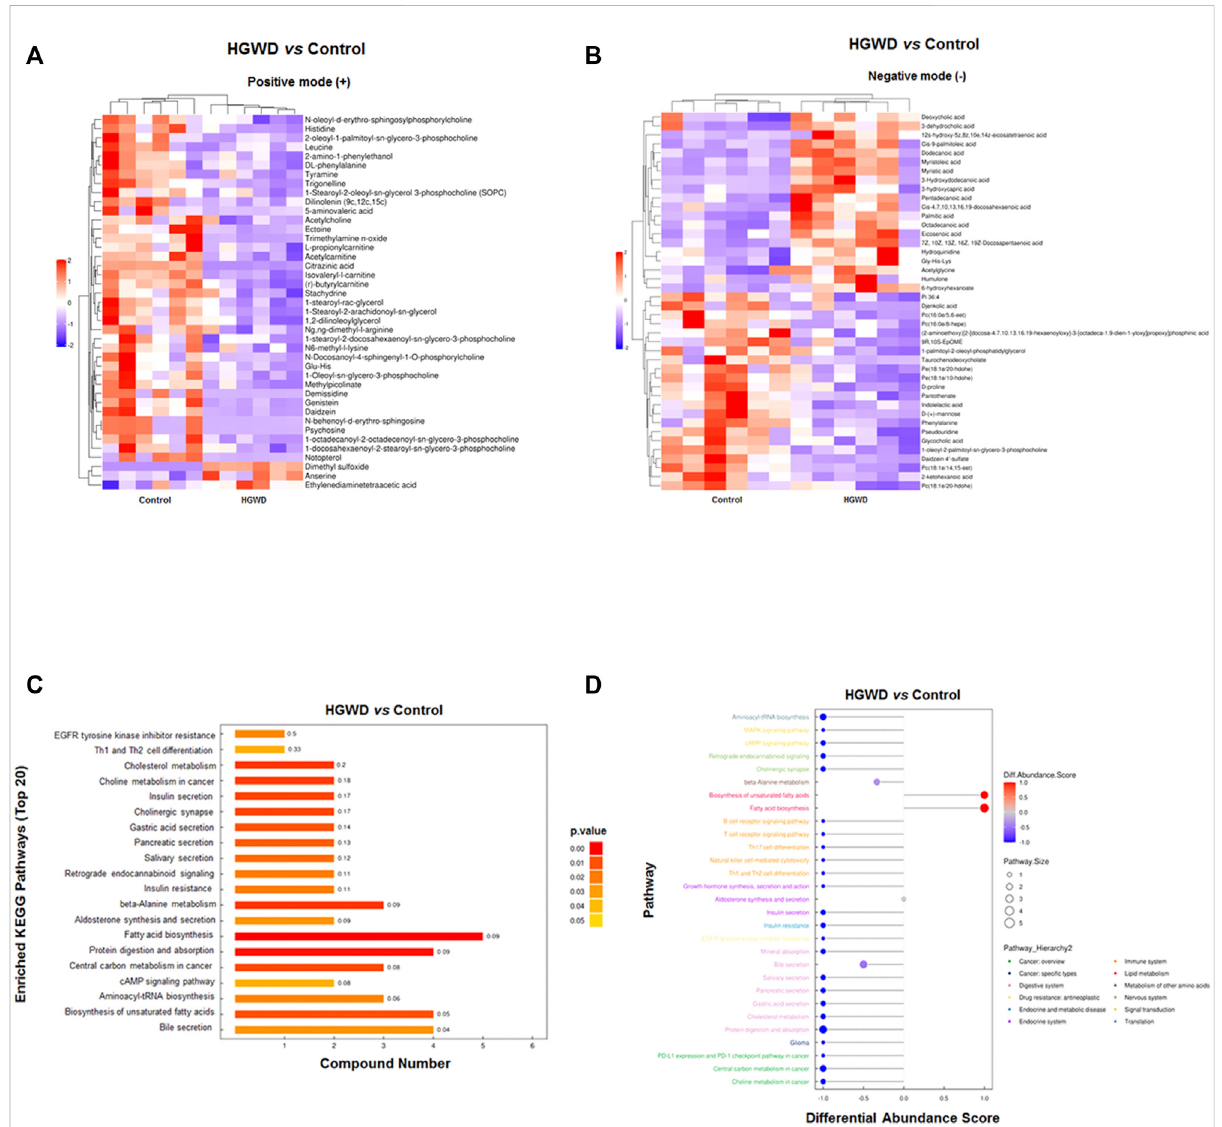
FIGURE 7 Altered plasma metabolites and related metabolic pathways in HGWD-treated xenografted CC tumors of C57BL/6 mice. (A,B) Heat plot of differentially expressed metabolites in HGWD-treated vs . control groups of mice. A, positive ion; B, negative ion. (C) The differentially expressed metabolites were enriched in the representative signaling pathways (KEGG). (D) Differentially expressed metabolites were also enriched in representative signaling pathways (KEGG, Pathway_Hierarchy two